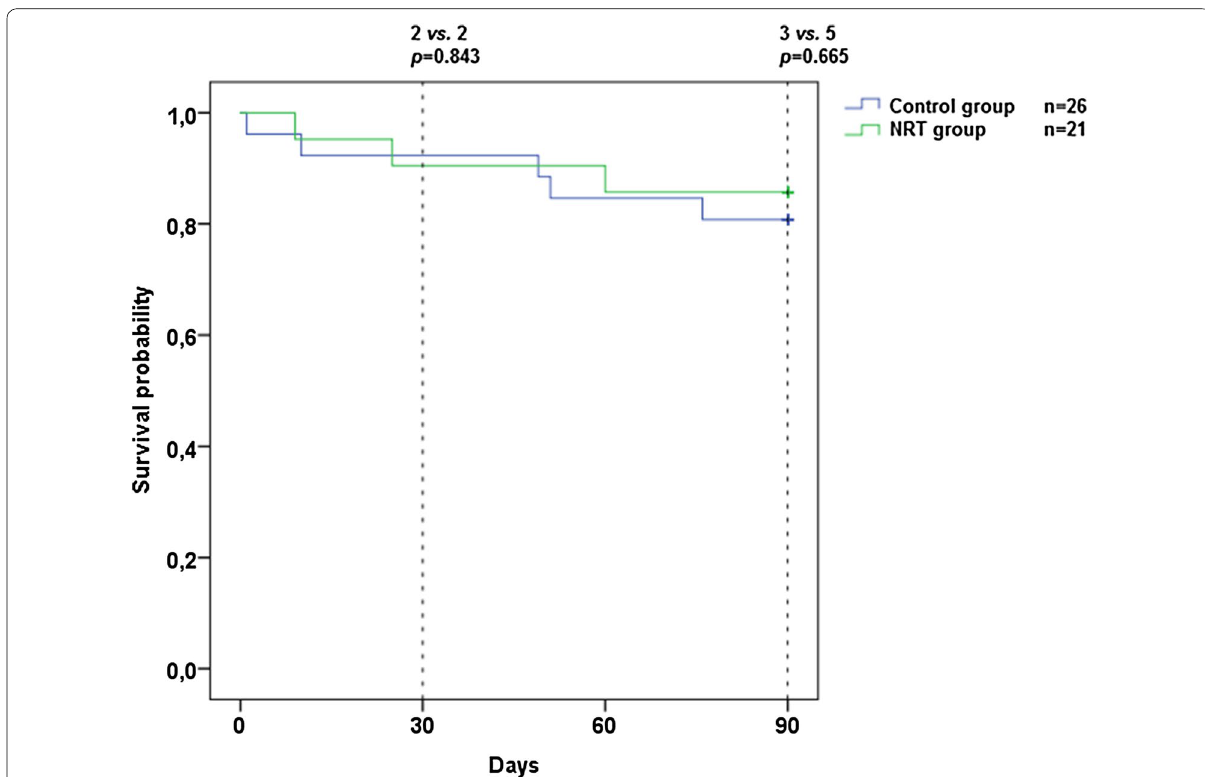
Fig. 1 30‑Day and 90‑day mortality comparing nicotine replacement therapy and placebo group. NRT nicotine replacement